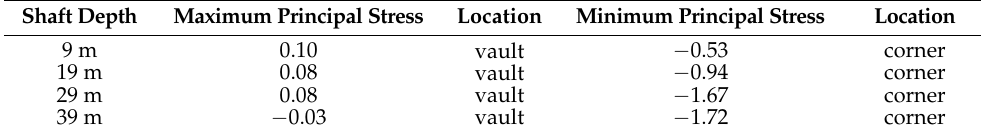
shaft section Figure 17. Diagram of maximum and minimum principal stresses under different shaft depths. Table 3. Greatest values of principal stresses at different depths (unit: